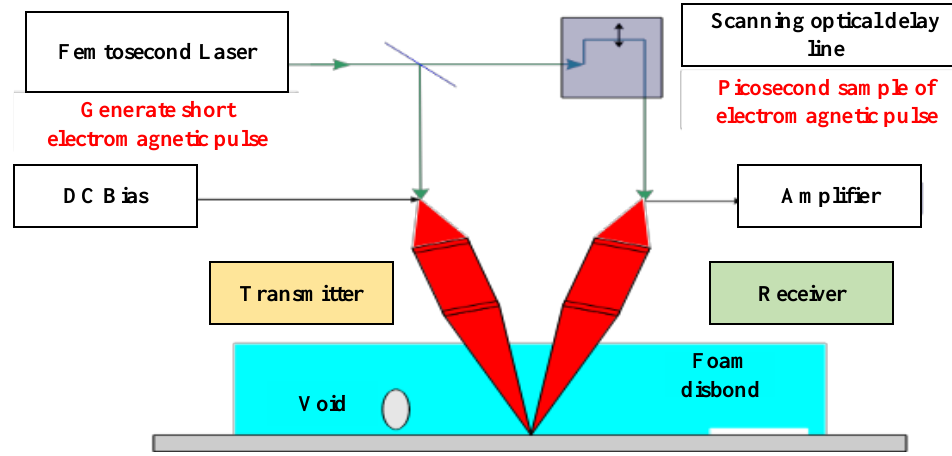
Figure 10. Terahertz method for fuel tank corrosion detection and monitoring under coating